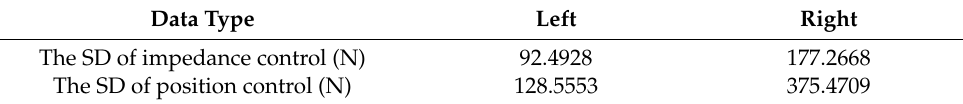
Figure 14. Comparison of the foot force between impedance control and position control. Table 7. Comparison of data of the foot force between impedance control and position